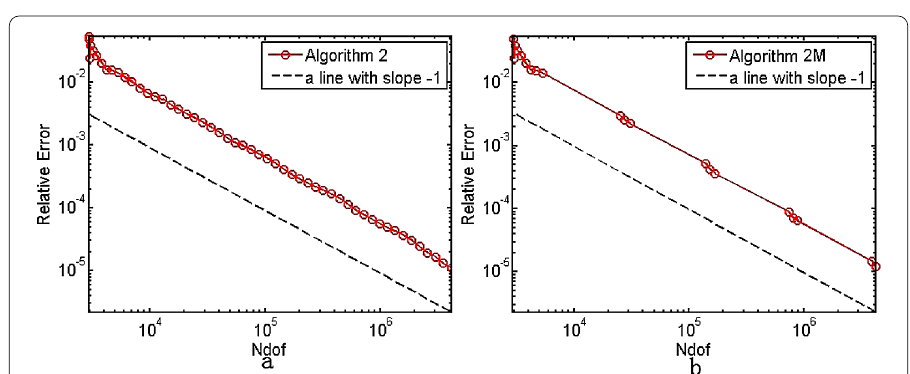
Figure 2 The convergence rates of the smallest eigenvalue from Algorithm 2(a) and Algorithm 2M(b)